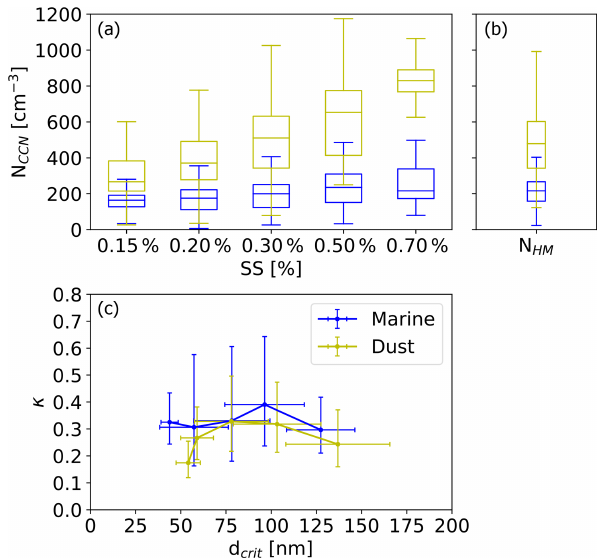
Figure 11. (a) Boxplot of measured N CCN during marine and dust periods at supersaturations (SS) from 0.15% to 0.70%; (b) Boxplot of N HM during marine and dust periods; (c) κ as a function of d crit during dust and marine periods. Dust and marine periods are shown in yellow and blue,